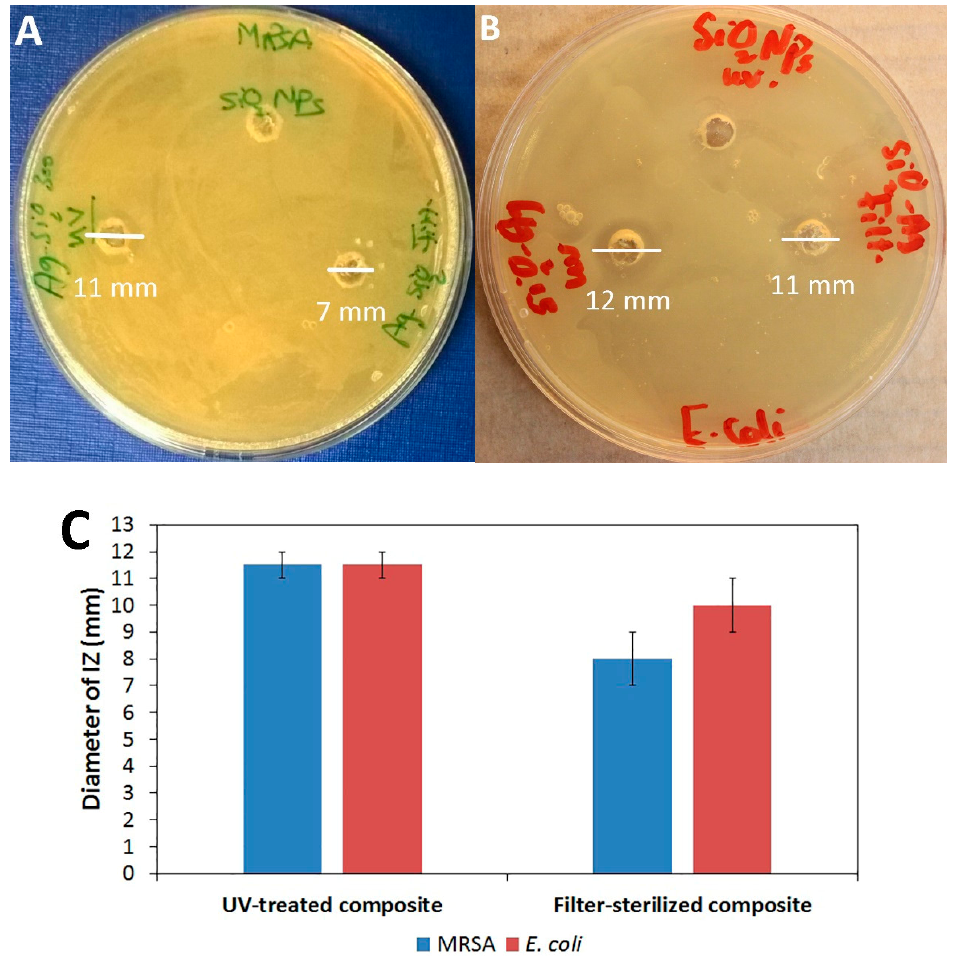
Figure 4. Antibacterial effects of UV-treated and filter-sterilized Ag–SiO 2 composites detected by the diameters of inhibition zones (IZs) on plates with ( A ) MRSA and ( B ) E . coli . ( C ) The diameters of IZs. The averages and standard errors of two independent agar diffusion assays are shown.